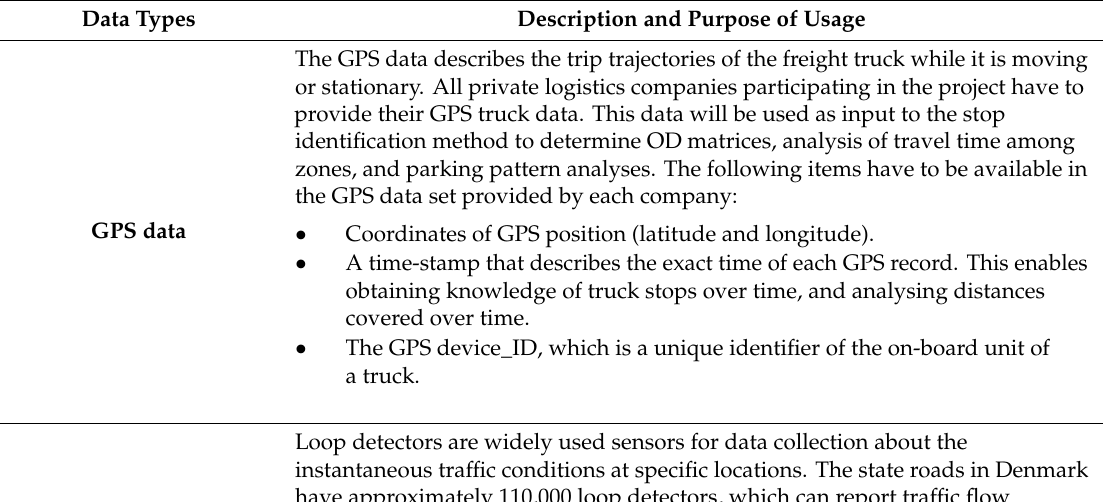
Table 3. Input data requirement for the proposed